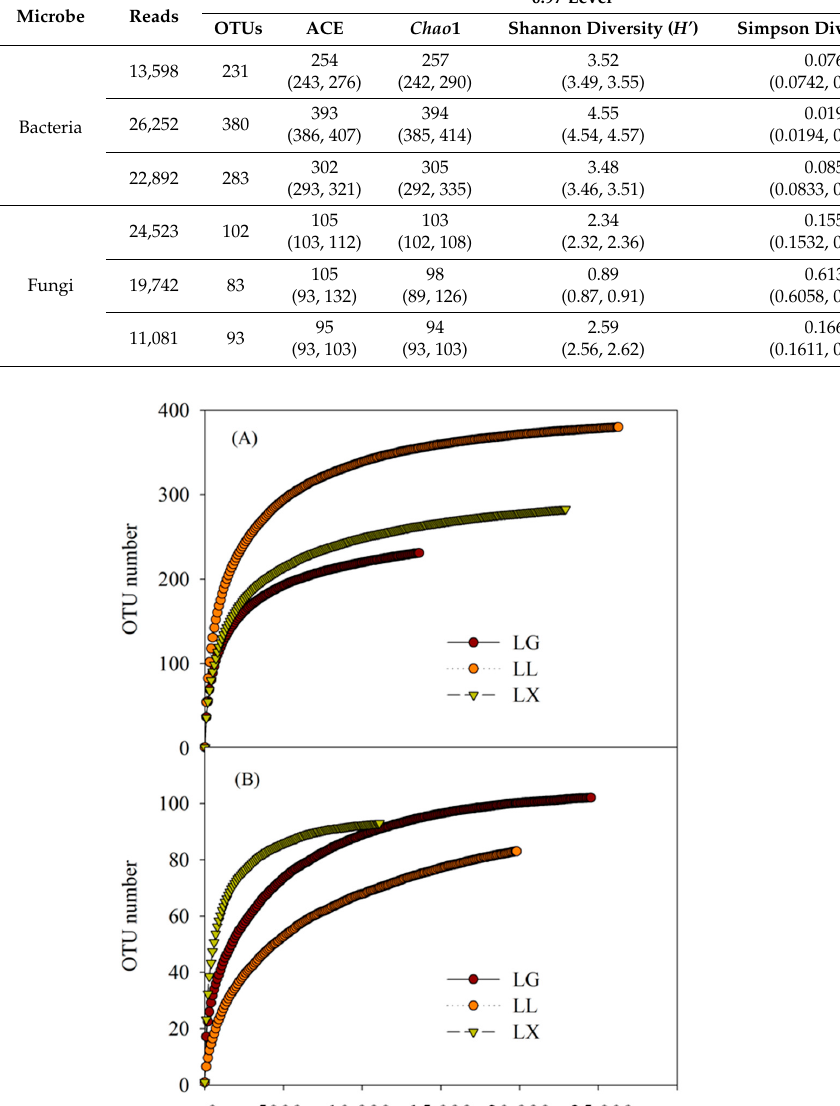
Table 4. Water bacterial and fungal community diversity index based on the Illumina Miseq sequencing data from Geming lake (LG), Lianhu lake (LL), and Xingqing lake (LX) in Xi’an City, Shaanxi Province, China.